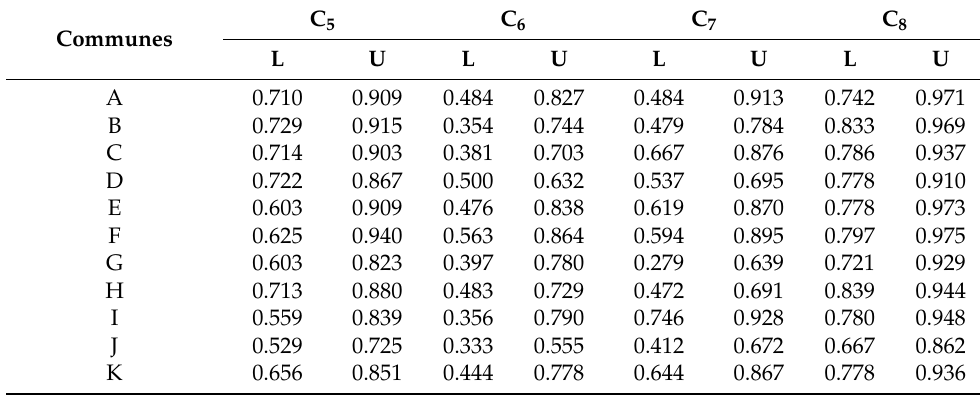
Table 6. Degrees of membership in the form of intervals for criteria C 5 –C 8 .